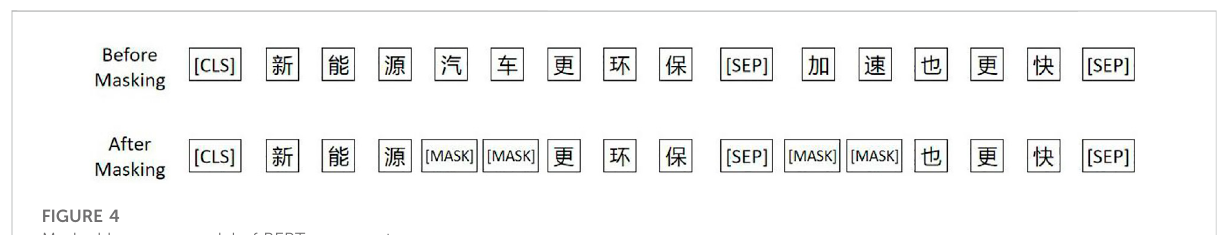
FIGURE 4 Masked language model of